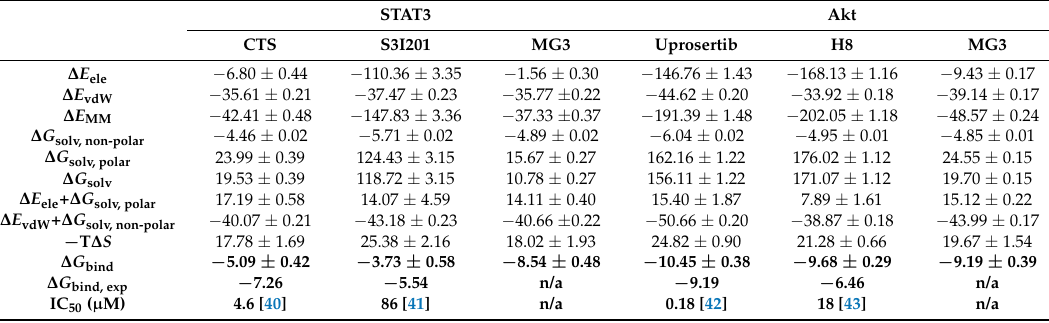
Table 2. The MM/GBSA ∆ G bind and its energy components (kcal/mol). The ∆ G bind, exp was calculated using the equation of ∆ G bind, exp = RTlnIC 50 , where R is the gas constant (1.985 × 10 − 3 kcal/mol/K), T is the experimental temperature (K), and IC 50 is the half maximal inhibitory concentration ( µ M).